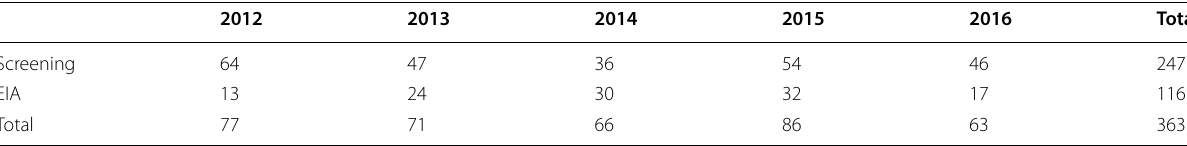
Table 3 Screening procedures by province Province Screening